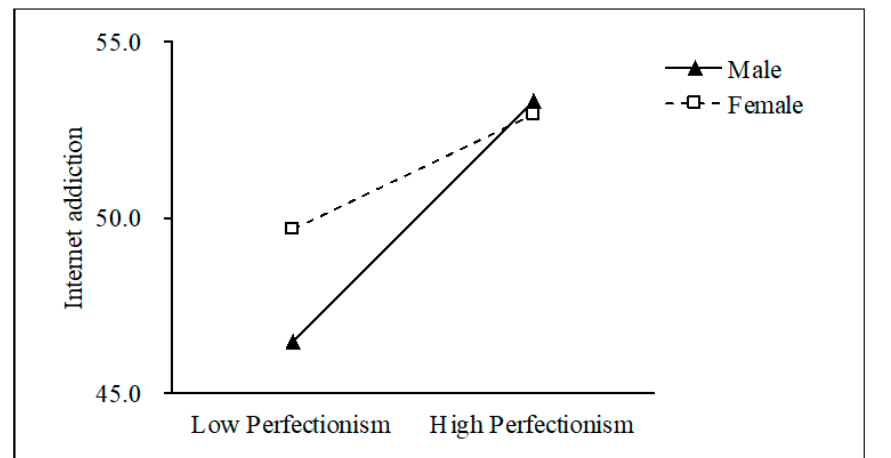
Figure 2. Gender as a moderator of the relationship between perfectionism and Internet addiction. Table 5. Result of moderated mediation analysis.